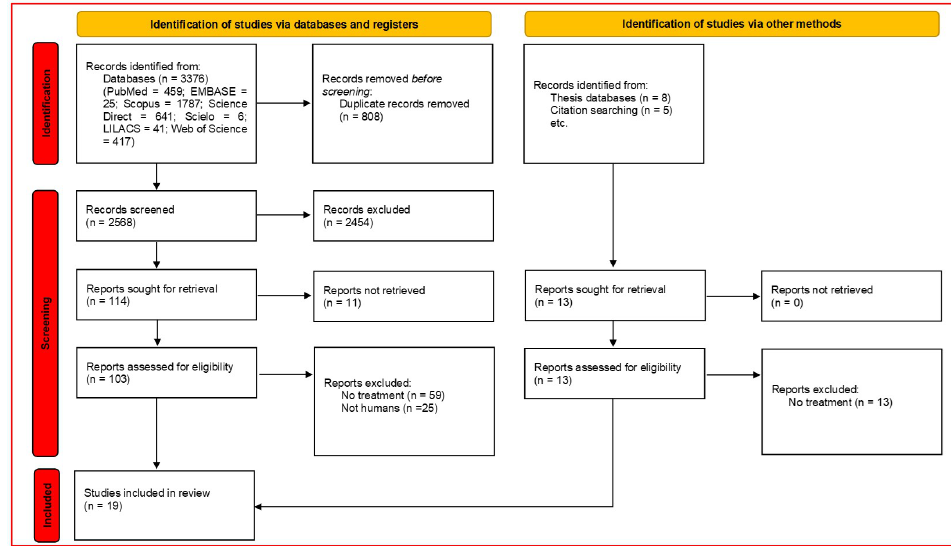
Fig 2. PRISMA flow diagram of this